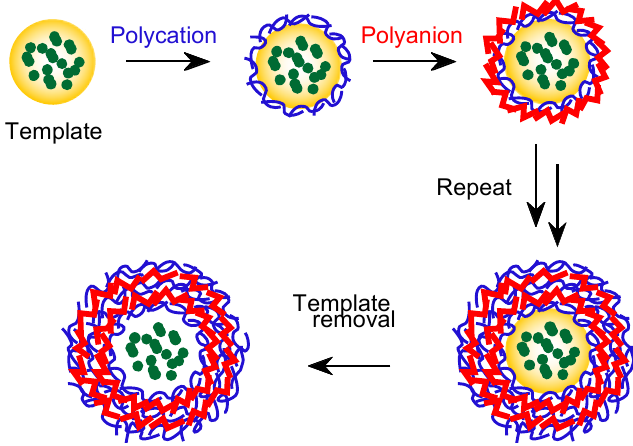
Figure 8. Construction of LbL film–based microcapsules. Reprinted (adapted) with permission from Sato et al . [120] Copyright (2011) The Japan Society for Analytical